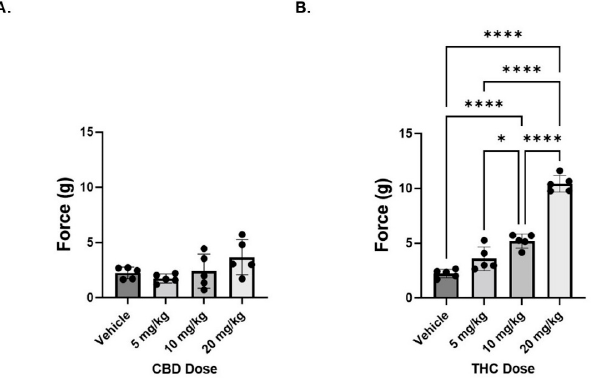
Figure 1. Dose response of cannabinoids on mechanical sensitivity in neuropathic male mice. ( A ) Mice were treated with CBD administered i.p. at 5, 10, or 20 mg/kg 1 h prior to measuring mechan- ical sensitivity. ( B ) Same as panel A except THC was administered. n = 5 mice per group. * p < 0.05, **** p < 0.001.